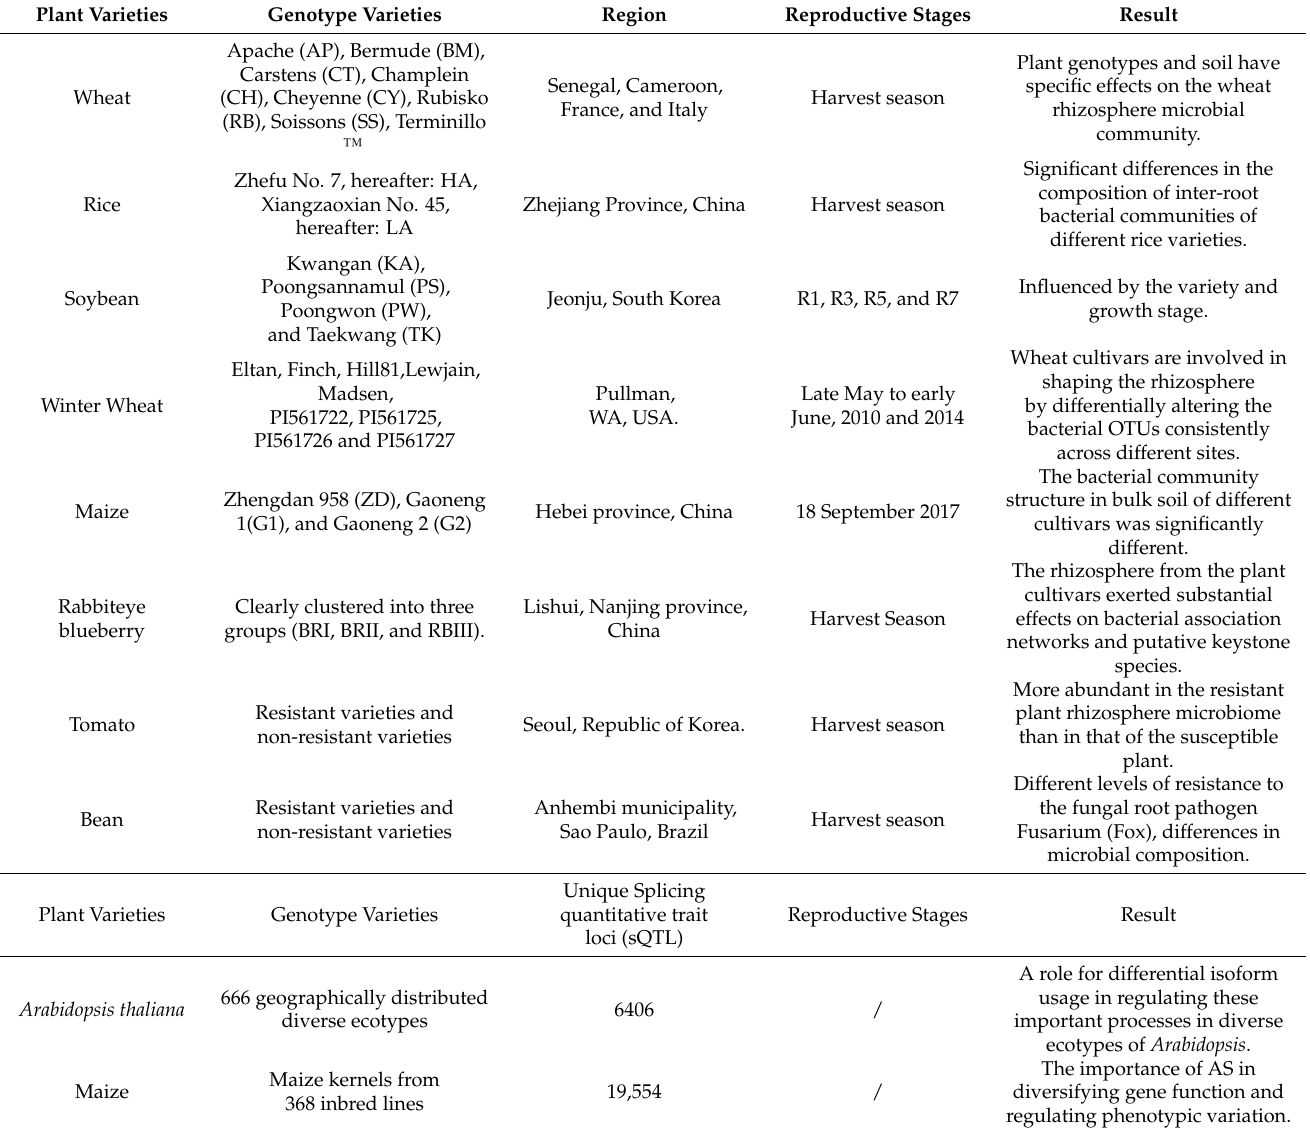
Table 1. A comparison of some representative microbial communities of different genotypes and a comparison of alternative splicing of plants of different ecotypes is